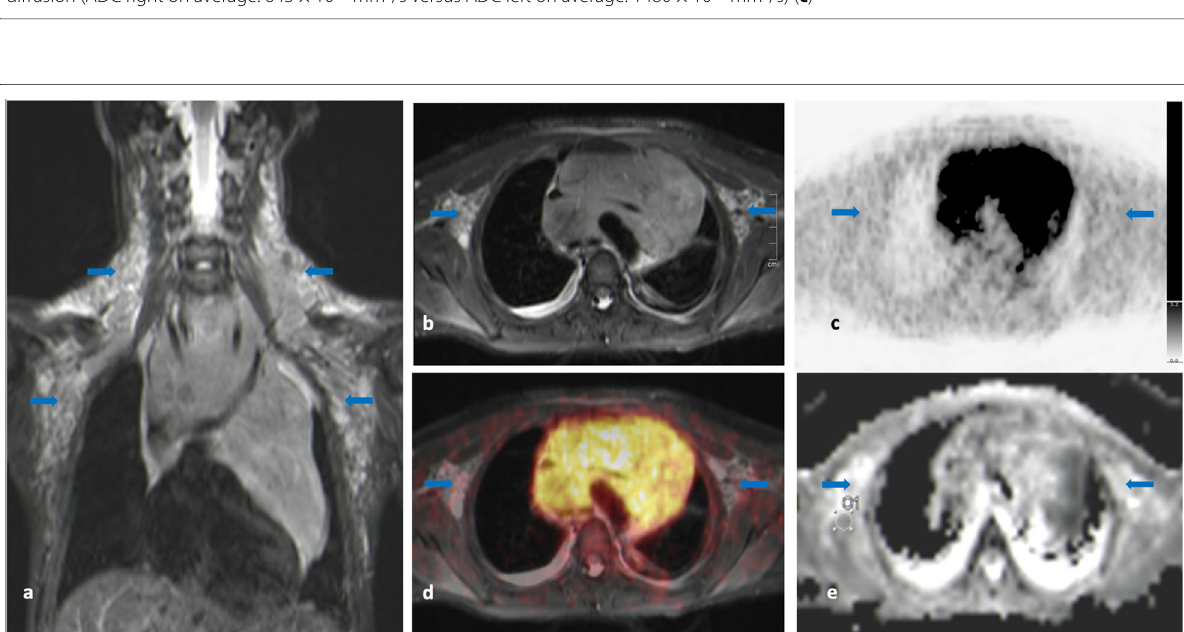
Fig. 2 a – e Neck, axillae and chest on T2‑TIRM image in coronal view ( a ); transversal view of axillae and chest on T2‑TIRM ( b ), [ 18 F]‑FDG‑PET ( c ), [ 18 F]‑FDG‑PET/MR ( d ) and DWI at b‑value of 800 ( e ): Lymphoma masses on both sides of the neck, with multiple, small lymph nodes extend caudally and filling both axillae (blue arrows) ( a , b ). In addition, diffuse lymphoma involvement of the thymus can be detected ( a ). Axillary lymph nodes exhibit physiological glucose uptake (SUV max right: 1.17; SUV max left: 1.25) ( c , d ) without restricted diffusion (ADC right: 1693 ADC left: 1746 10 –6 mm 2 /s) ( e ×